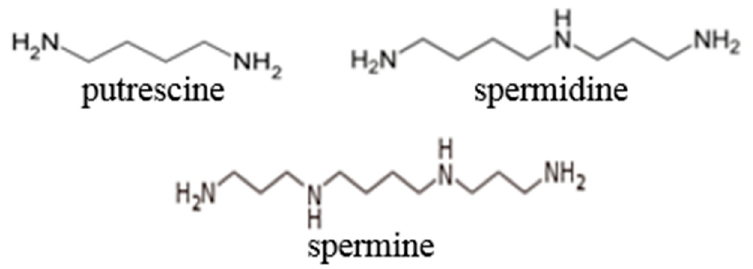
Figure 2. Chemical structure of polyamines.